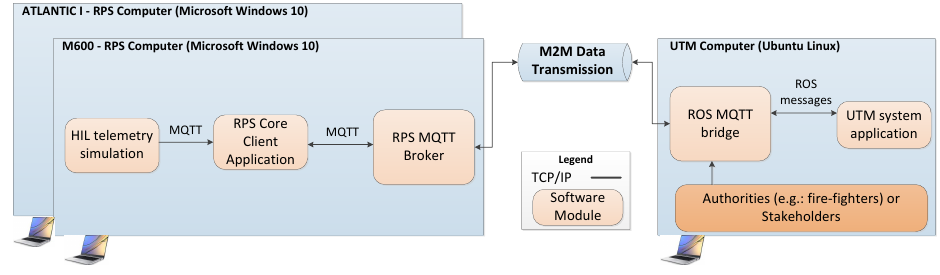
Figure 12. Setup for the experiments. The computers running the RPS for the two UAS and the UTM system were placed at remote locations and communicated through the Internet via the MQTT protocol.